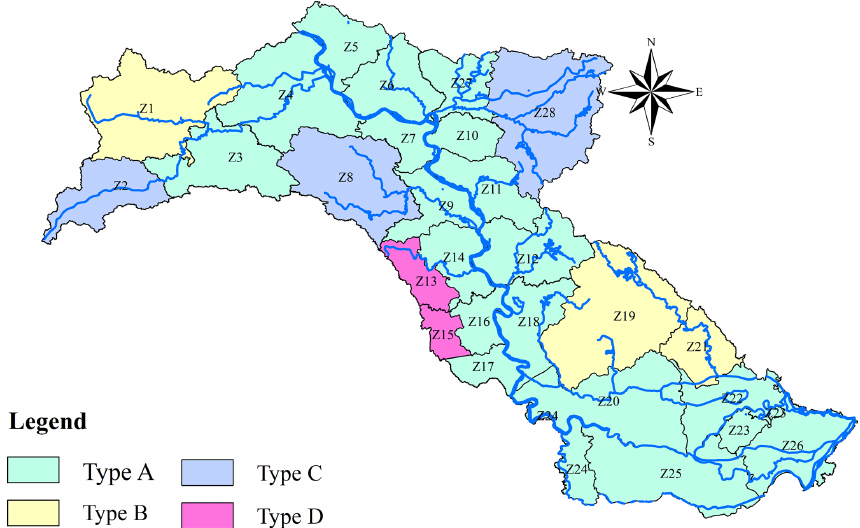
Figure 12. Spatial distribution of A, B, C, and D types of operational zones.